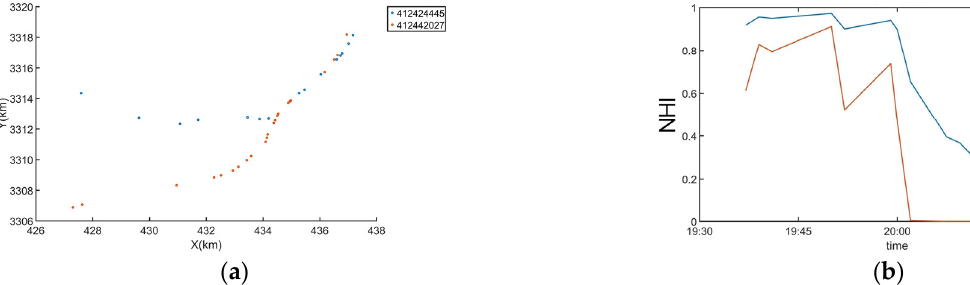
Figure 7. The crossing situation: ( a ) the trajectory of the crossing situation; ( b ) the NHI curve of the crossing situation.